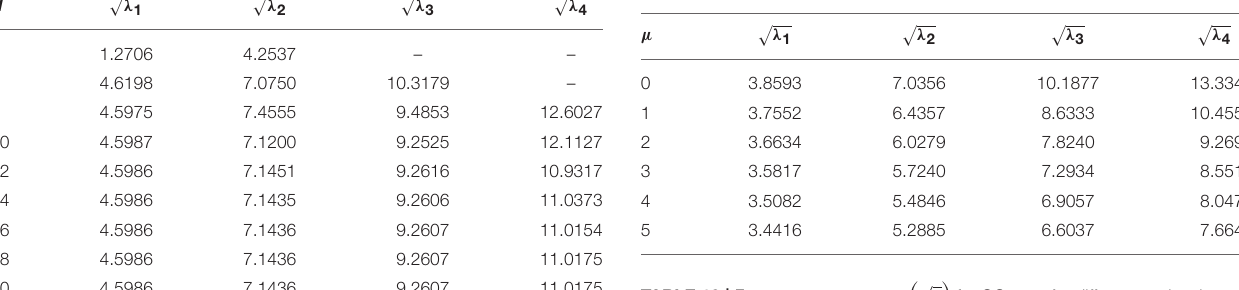
√ λ for CC case for different nonlocal (cid:16) (cid:17)